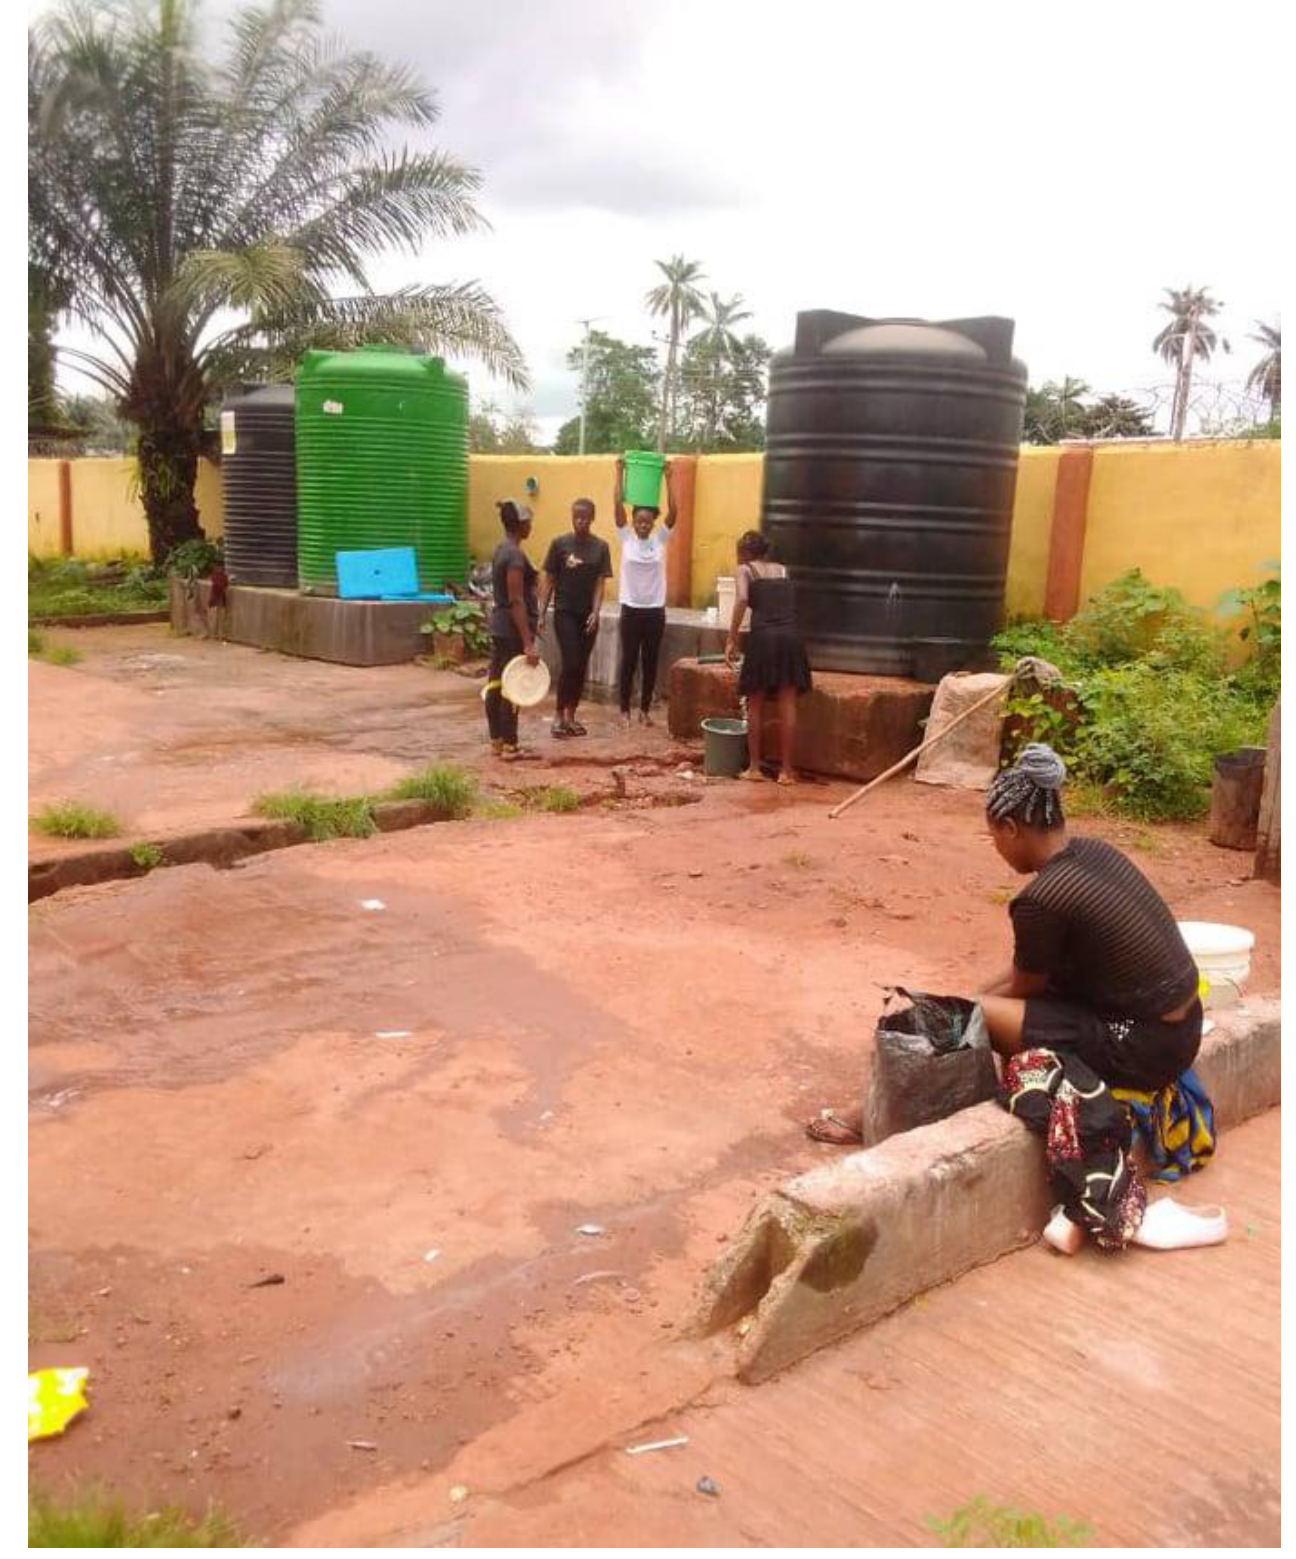
Figure A1. Community members collecting water with bucket.